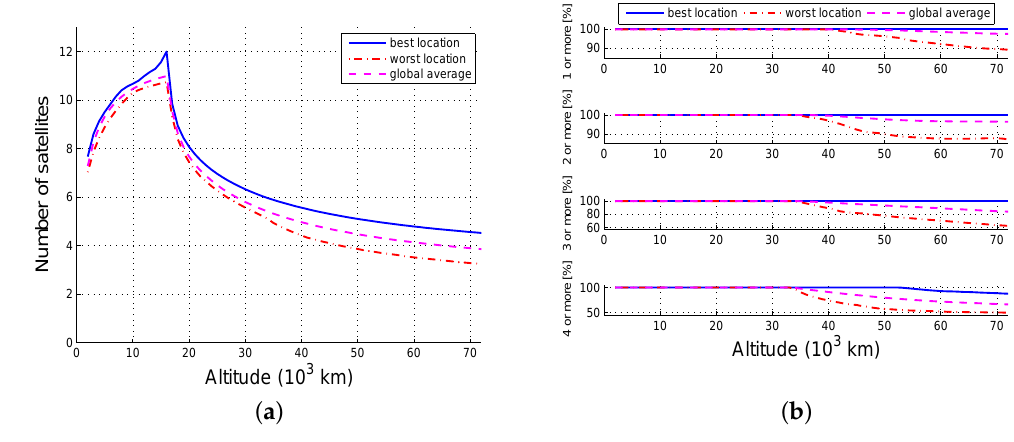
Figure 5. Availability as a function of altitude (1/2): ( a ) number and ( b ) probability.